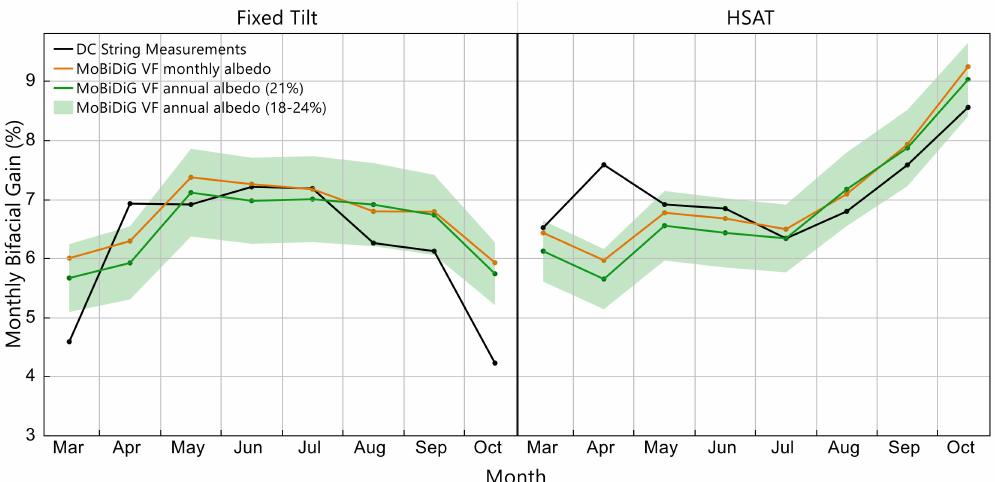
Figure 15. Sensitivity of albedo on the monthly bifacial gain (Equation (1)). All simulations here are performed with the MoBiDiG VF model. The orange curve shows the base case that uses monthly albedo (Figure 11), the green curve shows results using 21% annual average albedo, and the shaded green regions show the range of results obtained using annual albedo values of 18% to